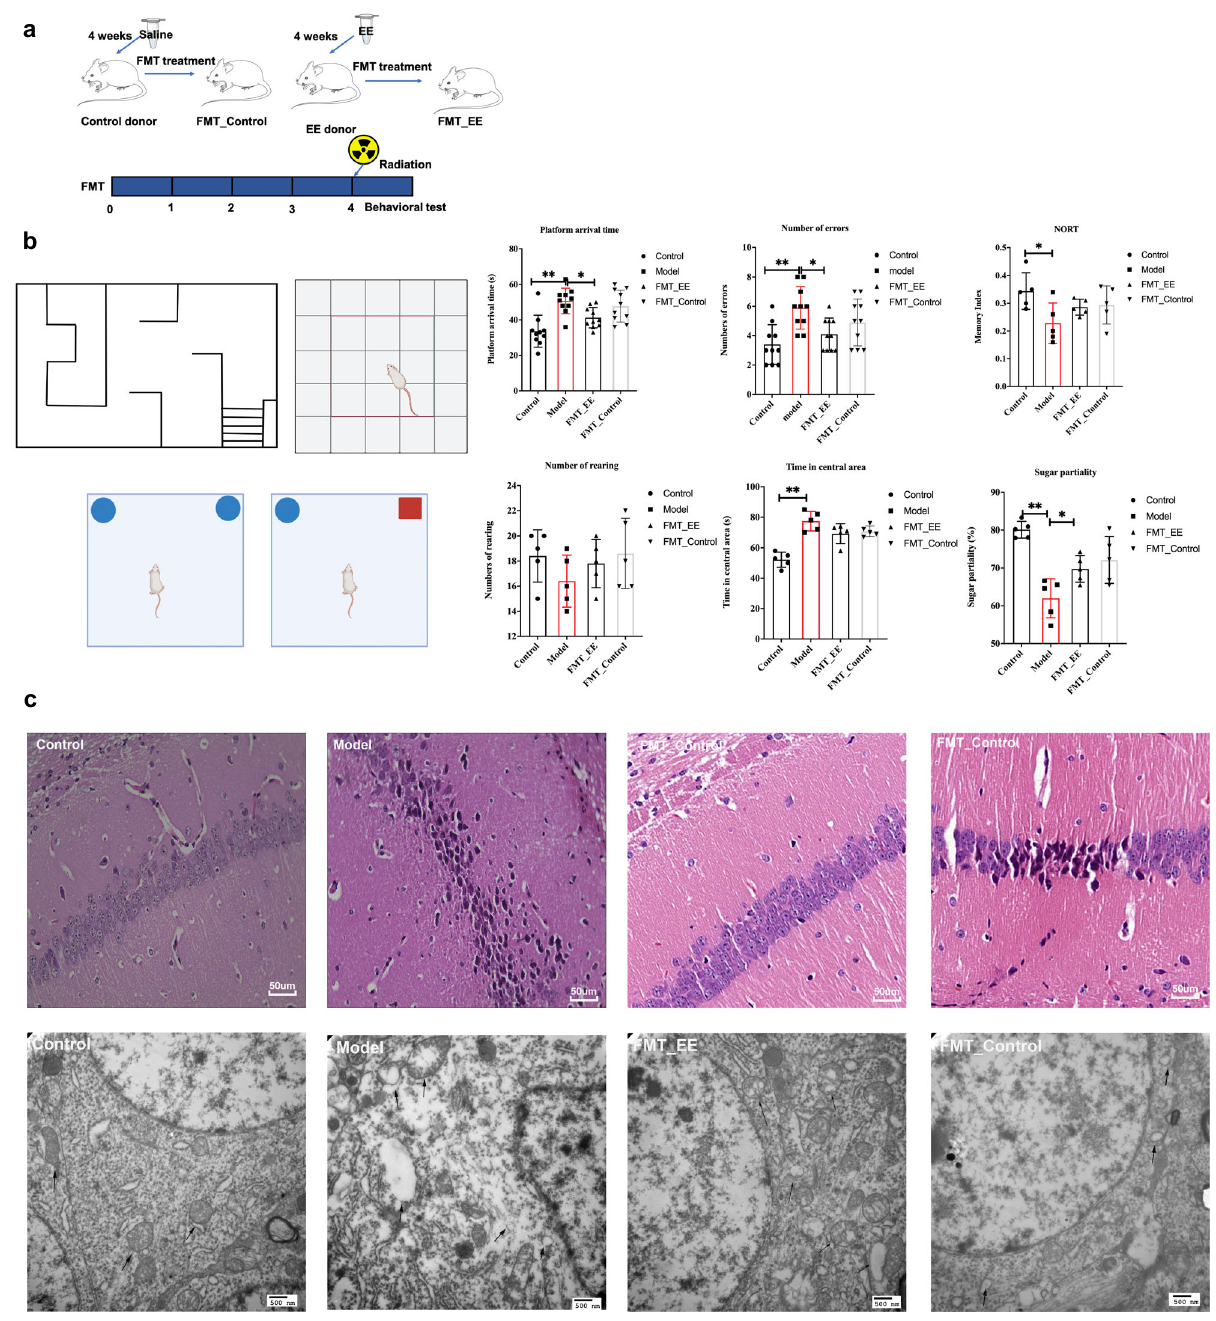
Fig. 8 FMT from EE-fed mice prevented cognitive impairment and damage of neuron morphology in irradiated mice. a Schematic of experimental design. b Behavioral performance of FMT mice. (Values are expressed as the mean ± SD ( n = 5). Statistical analyses were conducted using the one-way ANOVA followed by Tukey ’ s post hoc test, * p < 0.05, ** p < 0.01). c Histopathological features of hippocampus of FMT mice (H&E, scale bar = 50 μ m, TEM, scale bar = 500